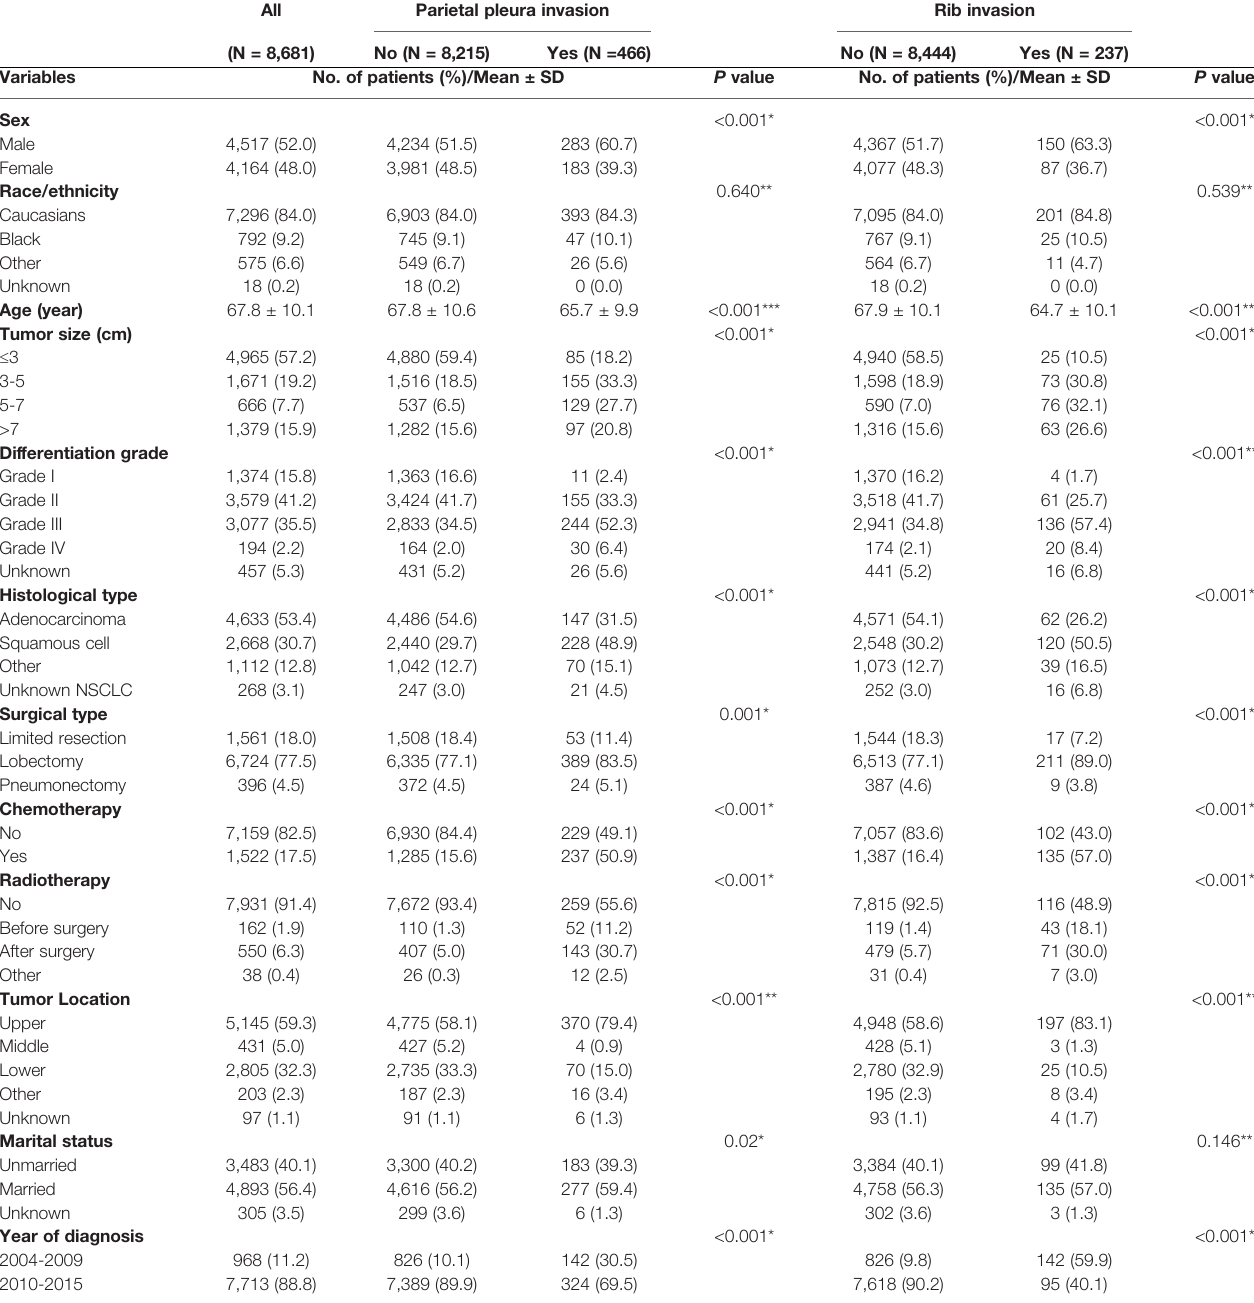
TABLE 1 | The clinicopathological characteristics for patients with different status of parietal pleura invasion and rib invasion. All Parietal pleura